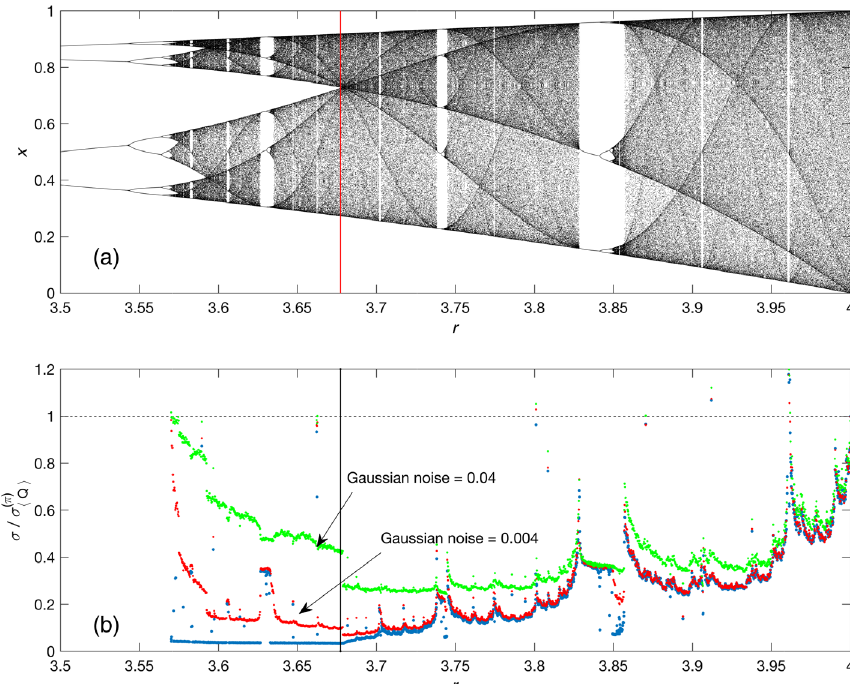
FIG. 9. Q distinguishes chaos from noise: Distribution of σ = σ for the logistic map. (a) The logistic map vs r . (b) Estimate for the h Q i standard deviation for h Q i , normalized by its value for π noise as given in Eq. (10). Each of the lacunae in the map in panel (a) has its counterpart as an interrupted trace in the curves below. Note that the dividing line at r c ¼ 3 . 6875 marks a boundary between spiked and normal pdfs. (See Fig. 10.) The lowest trace is that for pure deterministic chaos; the two above show its modification in the presence of additive Gaussian noise with σ ¼ 0 . 004 (as in Ref. [36]) and σ ¼ 0 . 04 . Note the separatrix at r c : To the left, the spiked pdfs are more quickly altered by a given stochastic noise level, while the normal pdfs on the right respond only